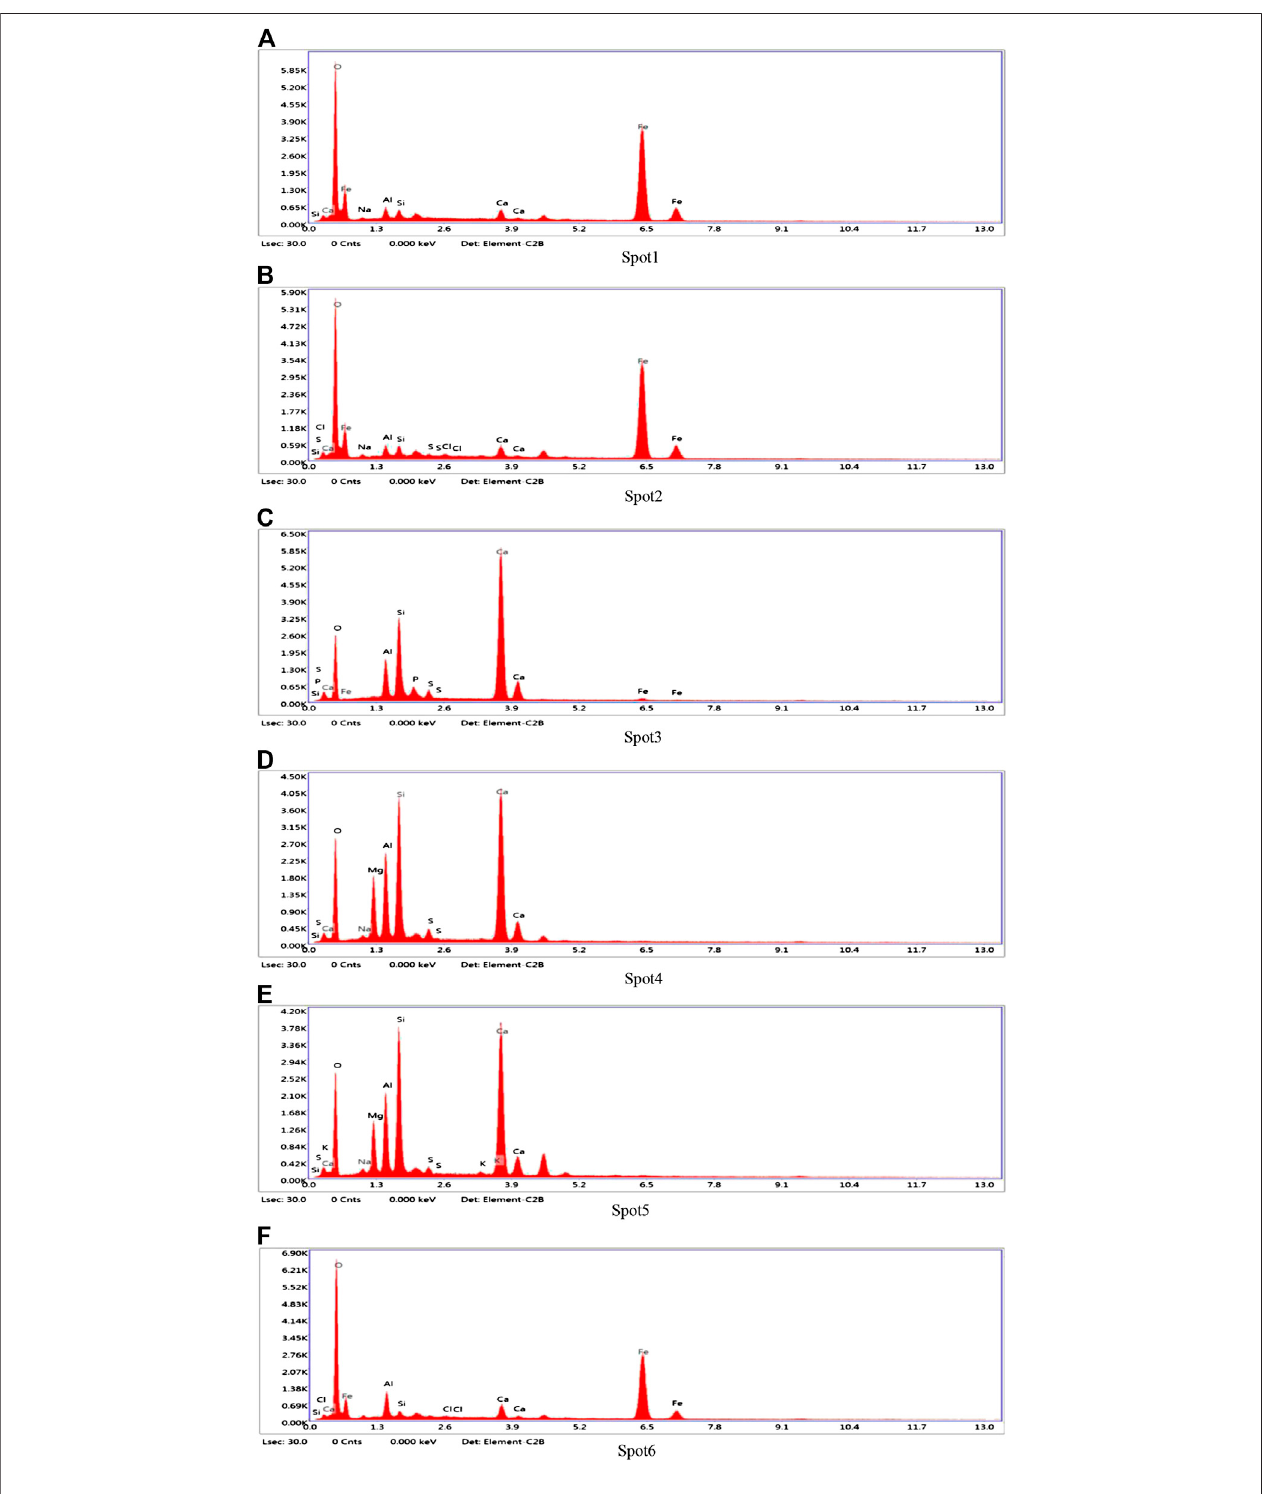
FIGURE 10 | EDS patterns of detection spot.